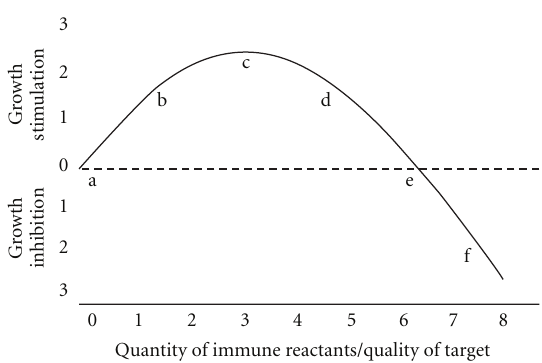
Figure 1: Immune response curve (IRC). Idealized curve derived from data in [7] showing the hormetic shape of the curve titrating the quantity of immune reactants against the e ff ect on tumor growth. Letters and numerals are arbitrary aids to